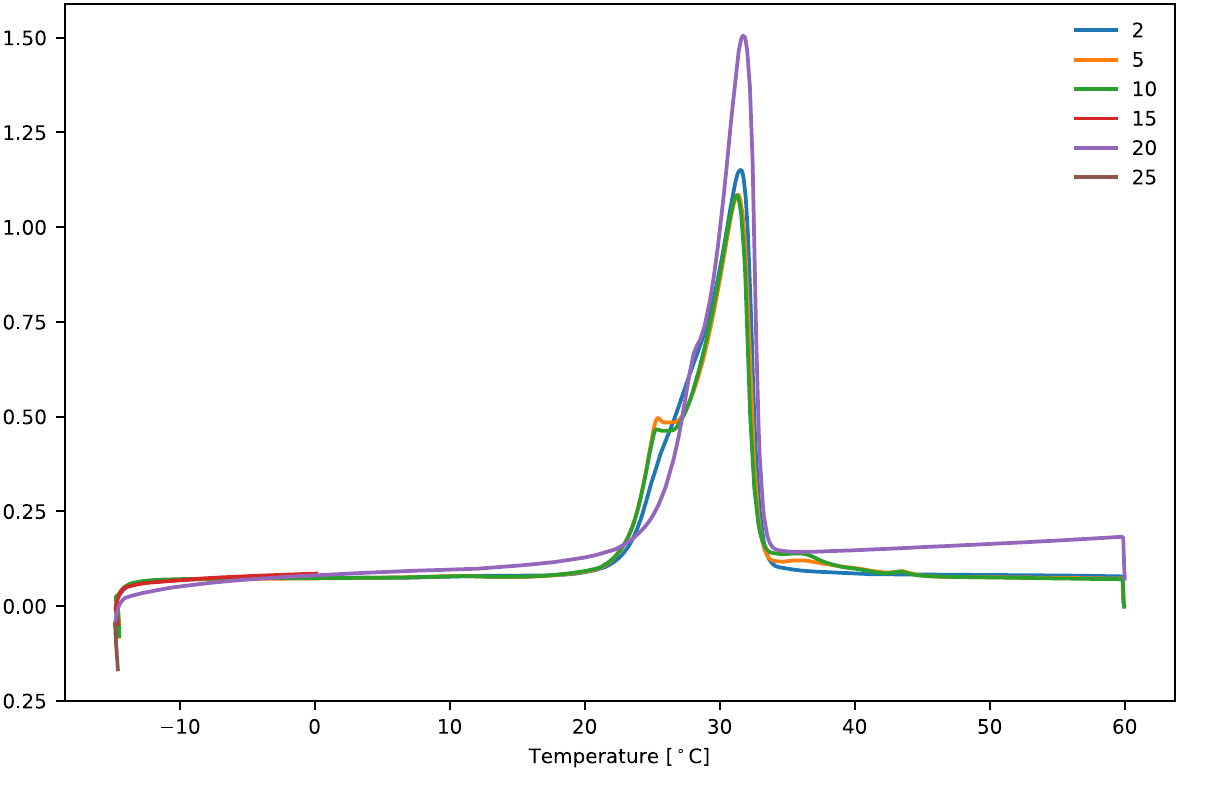
Figure 2. Differential scanning calorimeter (DSC) test-generated enthalpy curve for the mixture of calcium chloride hexahydrate (CaCl 2 · 6H 2 O) + sodium chloride (NaCl) + strontium chloride (SrCl 2 · 6H 2 O) (93% + 5% + 2%) for different thermal cycles. The average phase-change enthalpy for cycles 5–25 was approximately 180